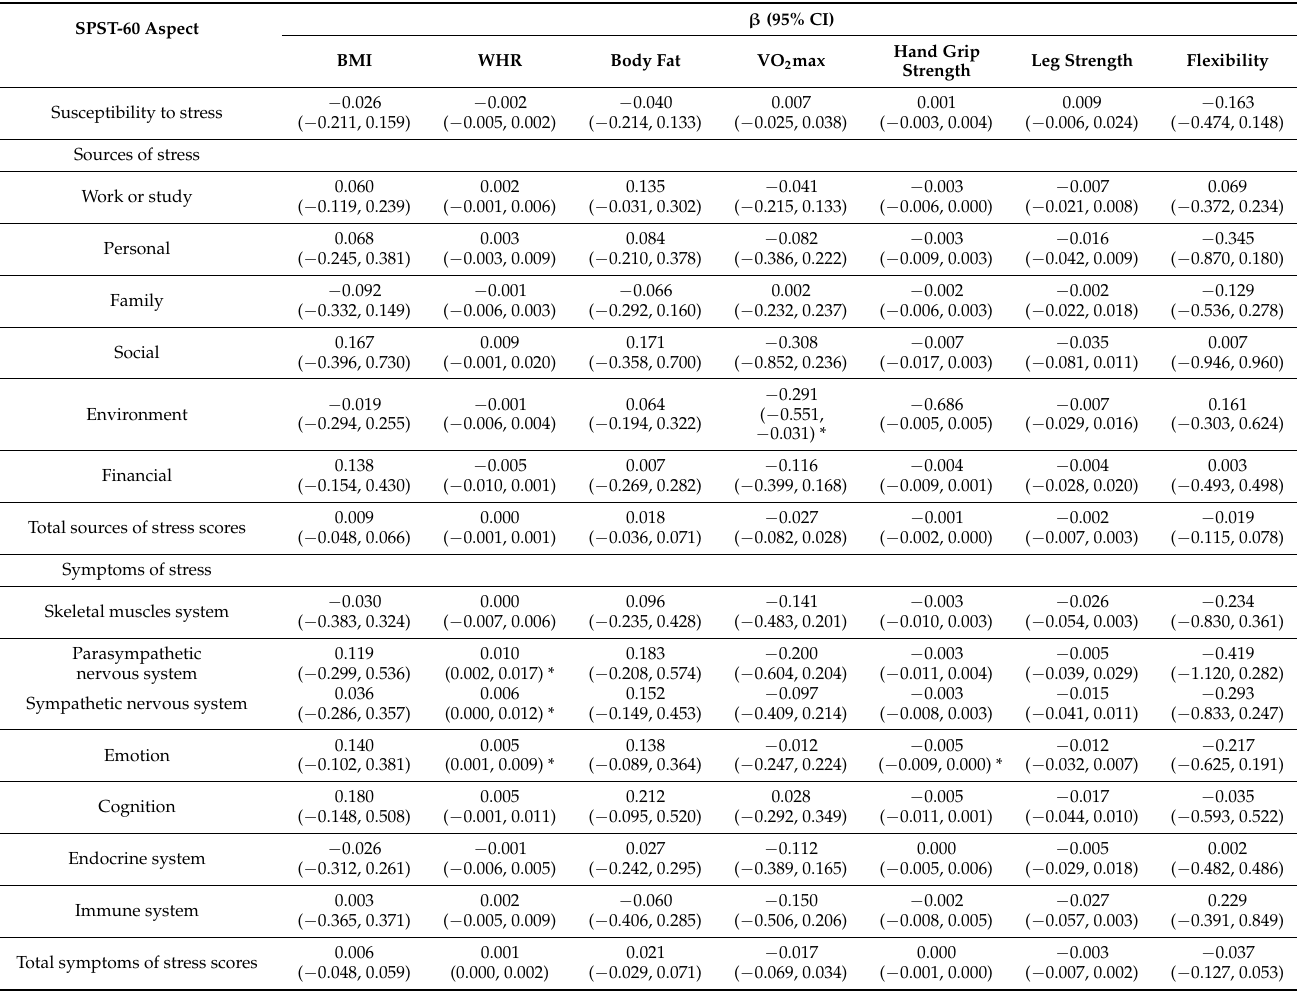
Table 4. Association between stress levels using SPST-60 scores and physical fitness of female university students ( n =